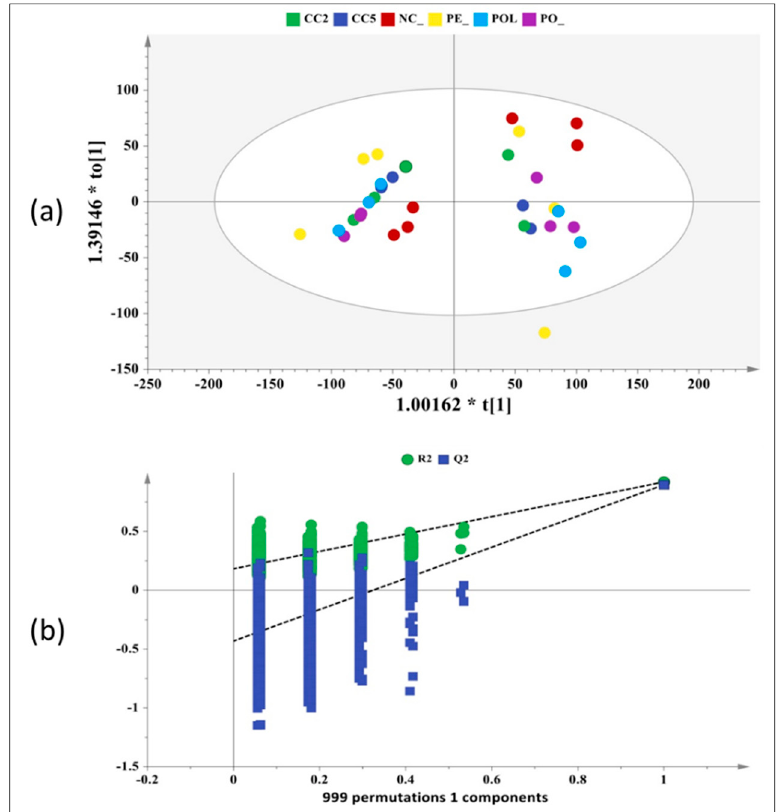
Figure 8. Illustration of multivariate statistical analysis of the 1 H-NMR data for the pre- and post-fermentation samples from 3 randomly selected volunteers. ( a ) Orthogonal projections to latent structures with discriminant analysis (OPLS-DA) scores map. (R2X(cum) = 0.68, (R2X(cum) = 0.92, Q2(cum) = 0.90, Pareto scaling, Hotelling T2 = 95%). ( b ) Validation of the OPLS-DA model by permutation analysis indicating that the extracted model is significantly different from a model built on random data. The permutation tests were carried out with 999 random permutations, thus providing significance of the model at the 0.05 level. PO: P. ostreatus strain 1123, POL: P. ostreatus strain LGM 22, PE: P. eryngii strain LGAM 216, CC2: C. cylindracea strain CC2, CC505: C. cylindracea strain CC505.